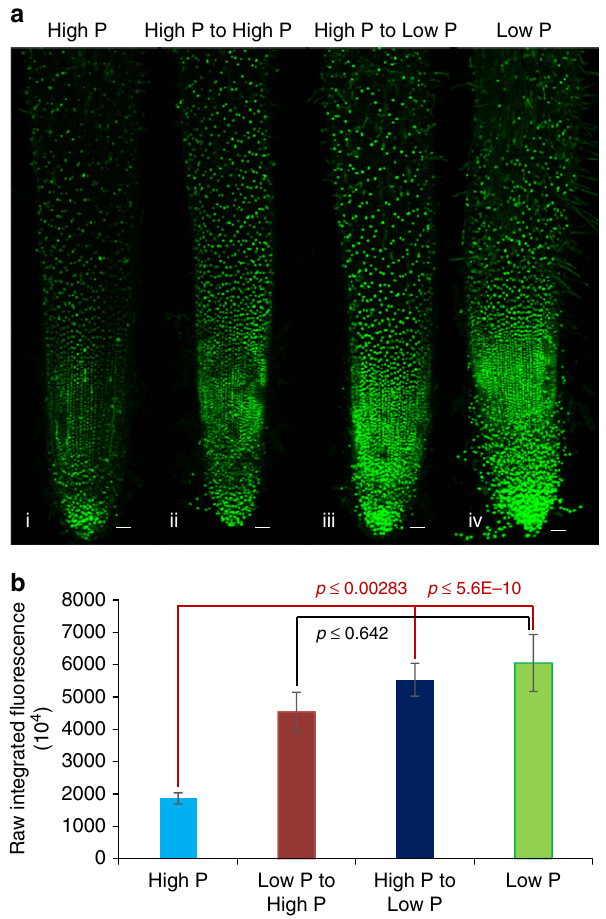
Fig. 5 Low P root auxin response is independent of plant P status.